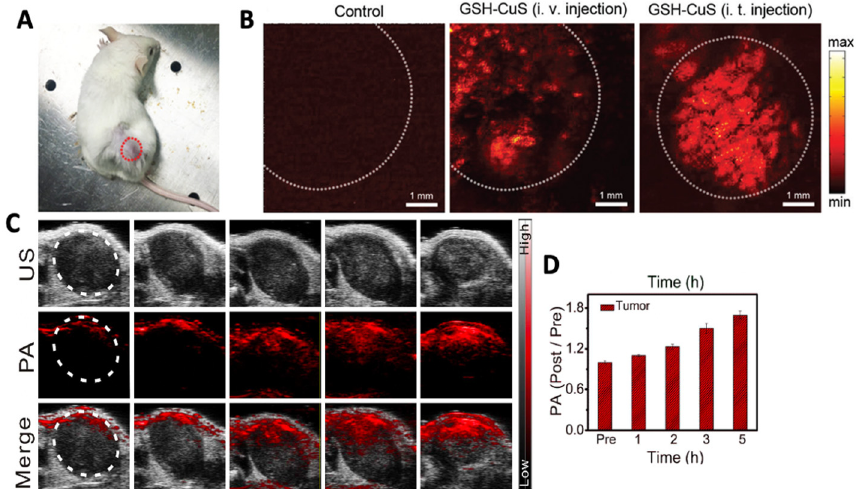
Figure 4. ( A ) 4T1 tumor bearing mice used for in vivo PAI. Laser scan section has been marked with a dotted circle. ( B ) Representative PA images taken before and after GSH-CuS NDs i.v. or i.t. injection Reprinted with permission from Ref. [52]. Copyright © 2023, Royal Society of Chemistry. ( C ) Representative images of PAI and ( D ) its quantitative estimation pre- and post- administration of FeS QDs at different time points. Tumor area has been demarcated with a white circle in ( B , C ). Reprinted with permission from Ref. [22]. Copyright © 2023, Elsevier.